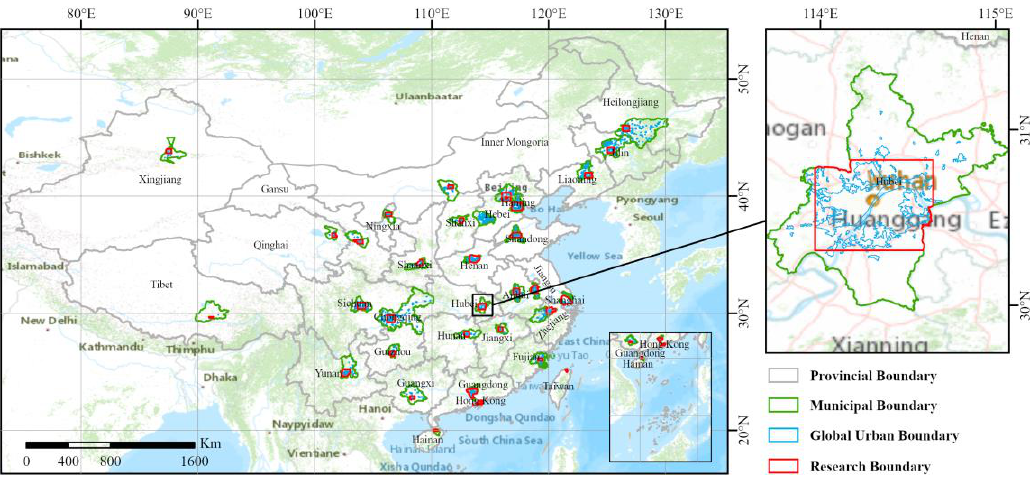
Figure 2. The geographic locations of the 34 Chinese cities. (Note: the gray line indicates the provincial boundary; the green line indicates the municipal boundary; the blue line indicates the global urban boundary; we take Wuhan city as an example to illustrate the determination of the research boundary, the red line.)